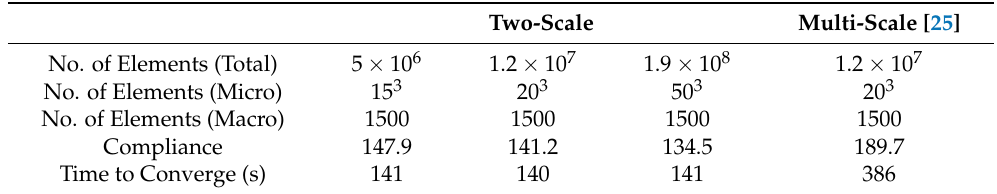
Table 4. Convergence time comparison of different topology optimization methods. Best results are specified by bold